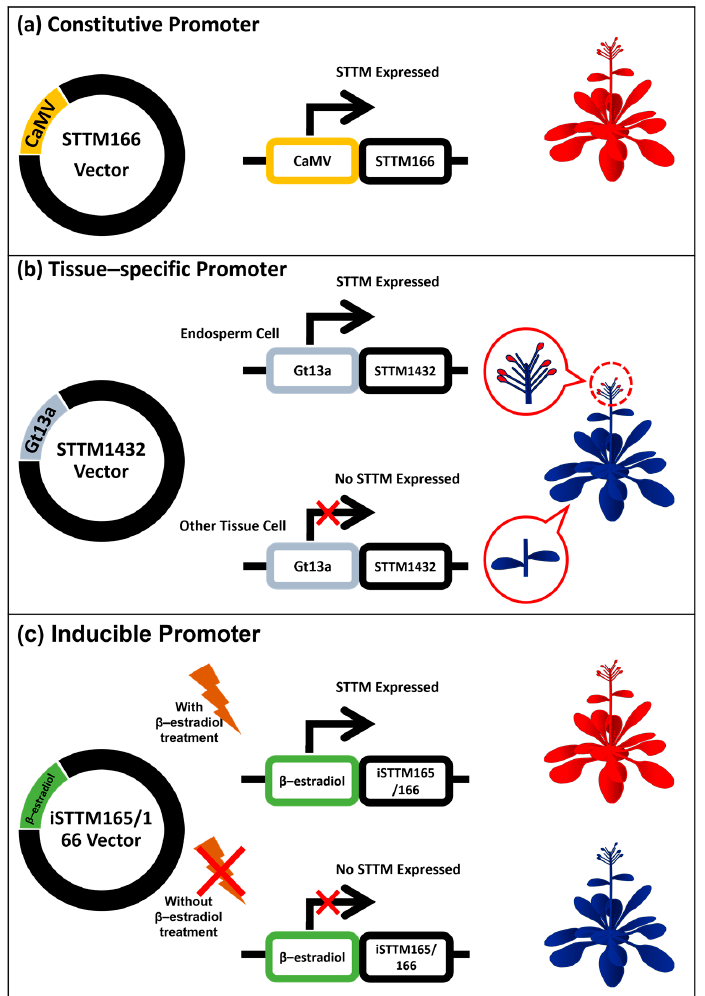
Figure 5. Activation of STTM expression in three different spatial–temporal types of miRNA silencing: ( a ) a constitutive promoter for continuous expression in cell to various tissues and conditions; ( b ) as a tissue-specific promoter expressing STTM in the endosperm cell but not in other tissues; and ( c ) as an inducible promoter that expressed STTM only when plants were treated by a chemical trigger ( β -estradiol). The red color indicates STTM expression, while the blue color indicates no STTM